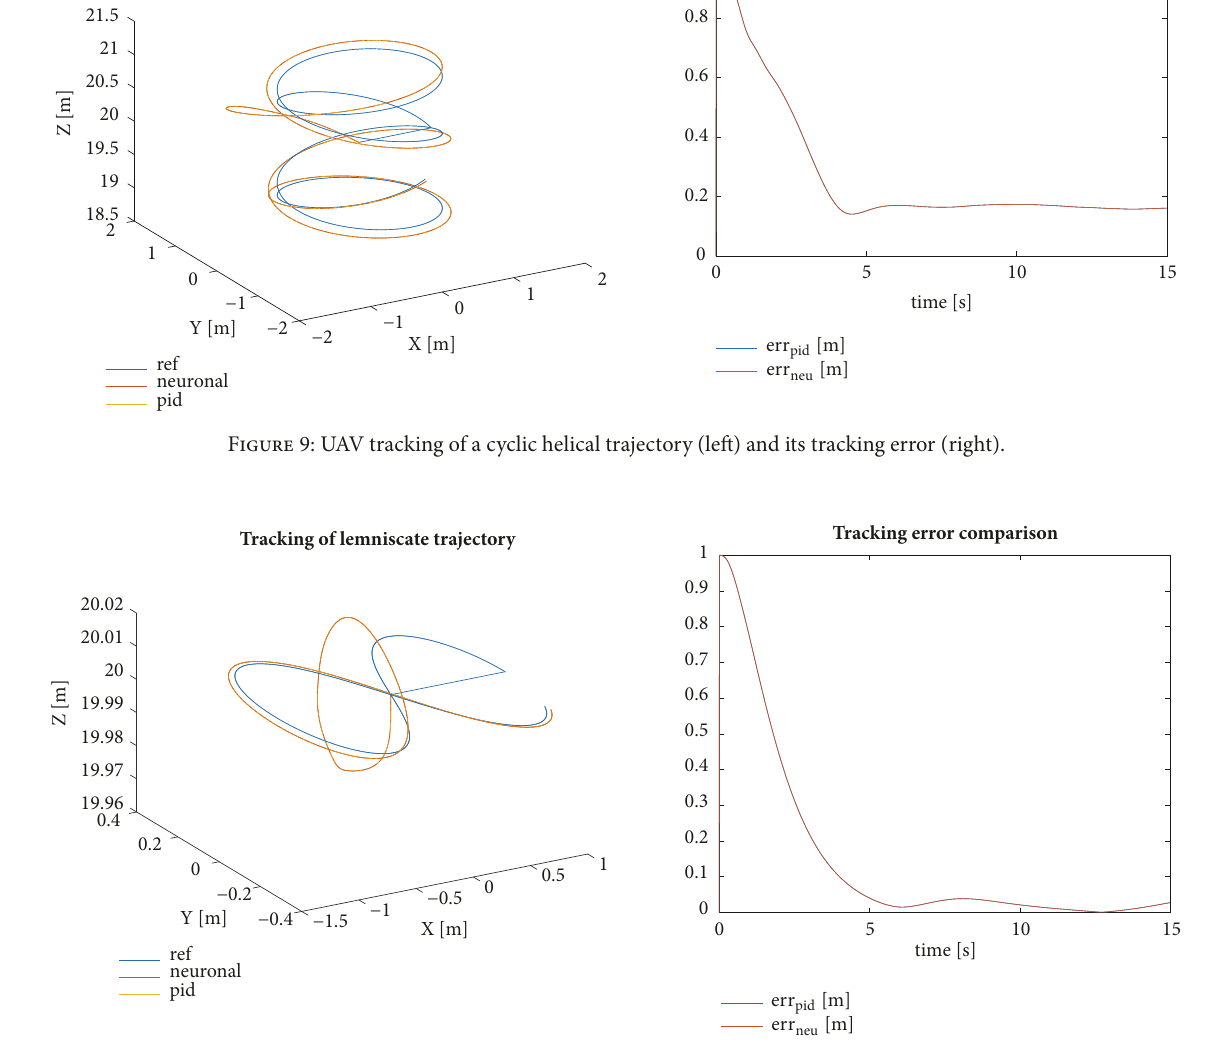
Figure 10: UAV tracking of a lemniscate trajectory (left) and its tracking error